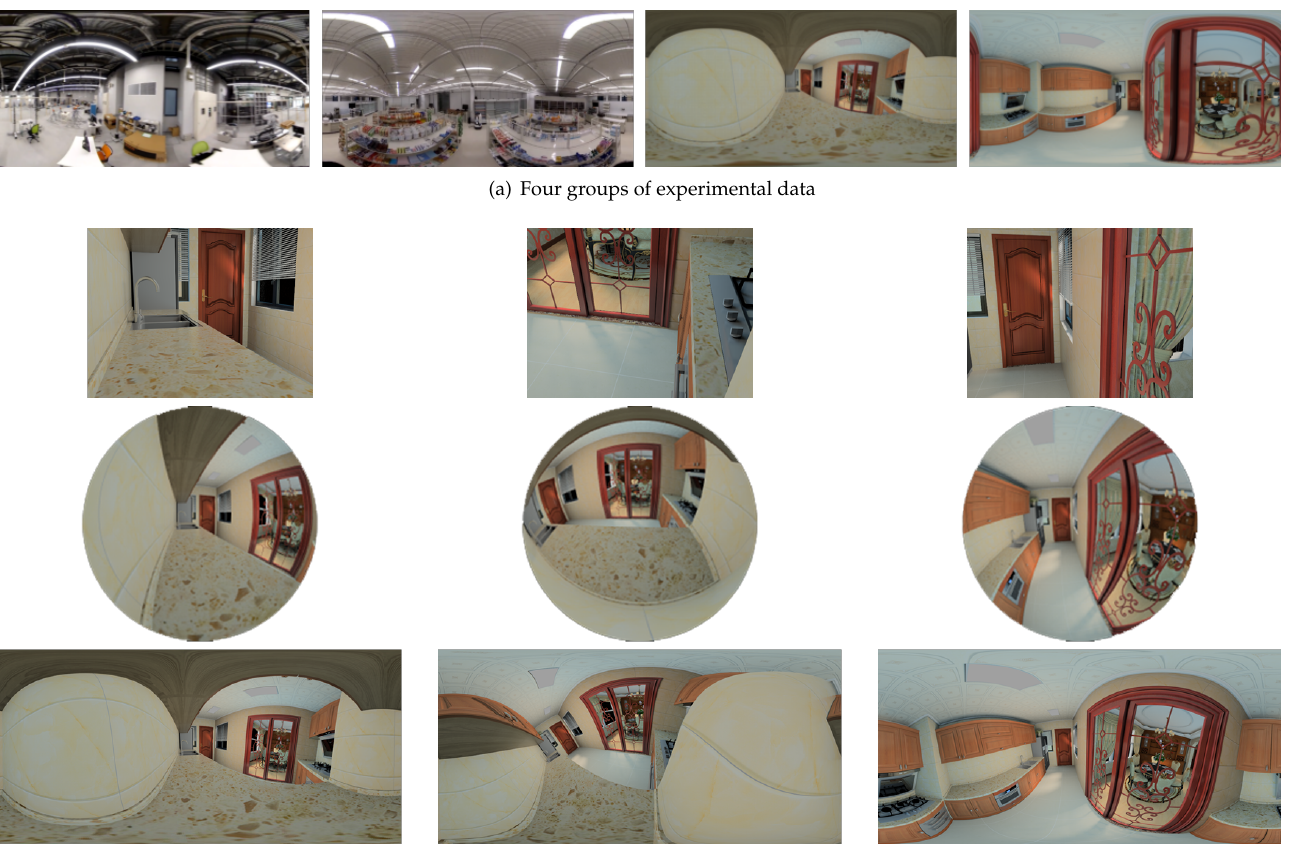
Figure 7. Experimental image